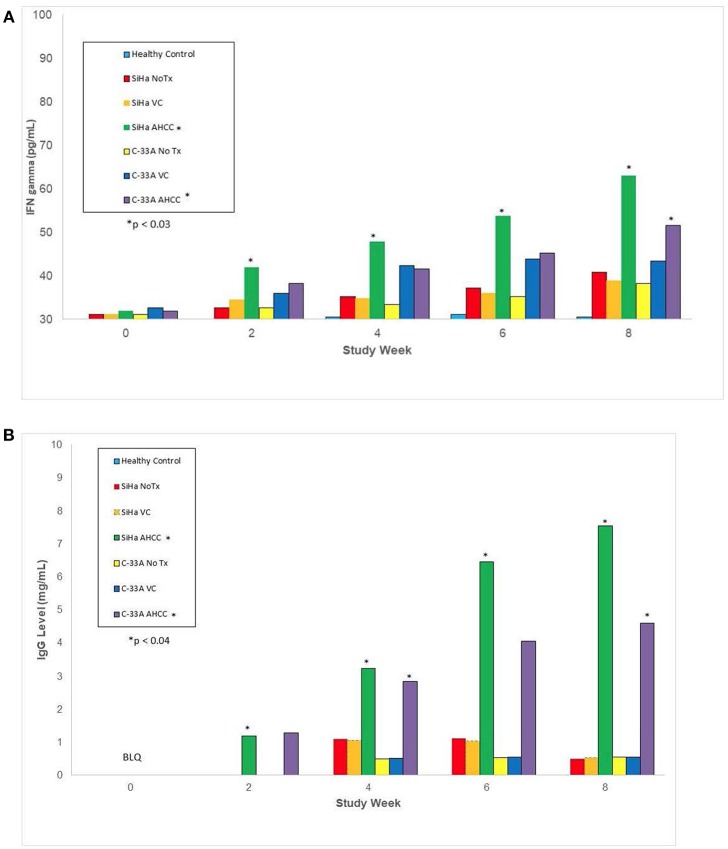
This represents immune marker data from animal studies including the IFN-γ, type II interferon associated with clearing viral infections, and IgG, antibody associated with immune response to viral infections, levels after 30 days AHCC 50 mg/kg supplementation once daily in mouse models as described in methods and materials. AHCC daily supplementation on IFN-γ and IgG levels increased with time and correlated with successful clearance of HR-HPV infections in the SiHa (HPV 16/18+) mouse model. (A) IFN-γ level response (NOTE: y-axis starts at 30 pg/mL) p < 0.03 (B) IgG1 level response, p < 0.04.